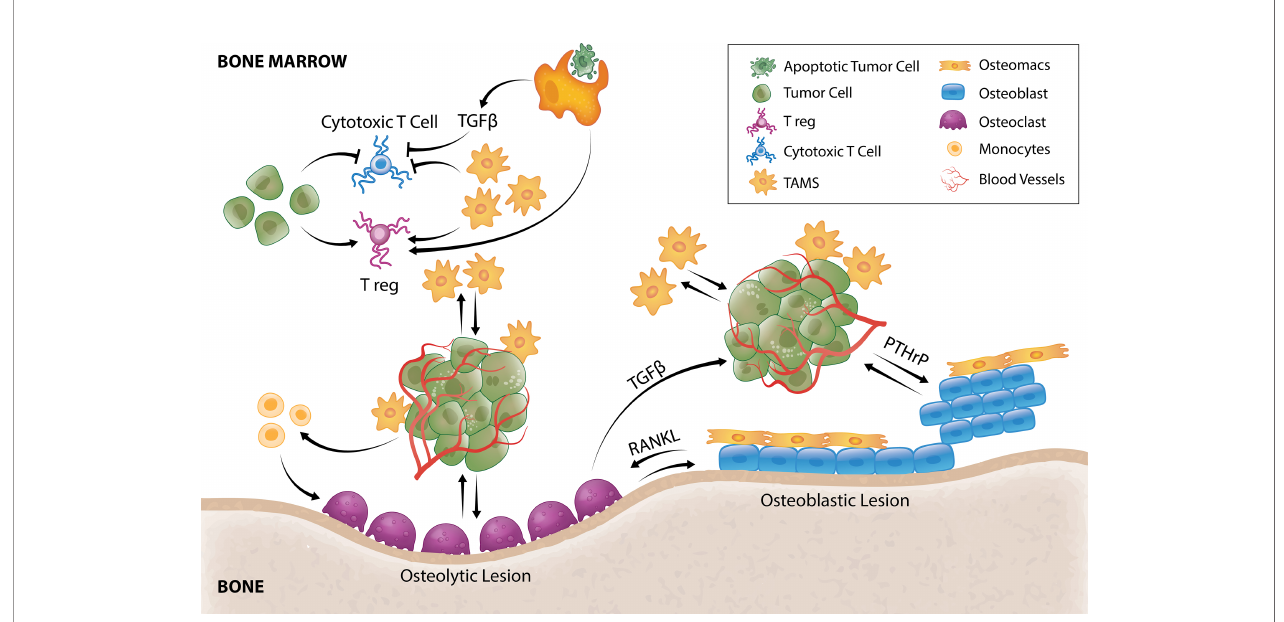
FIGURE 2 | TAM and tumor crosstalk promotes tumor survival and outgrowth in bone. Efferocytosis of apoptotic tumor cells by TAMs results in TGF b secretion that inhibits cytotoxic T cells and stimulates Tregs. TAMs and tumor cells can also directly hijack immune checkpoint pathways to negatively regulate T-cell anti-tumor function. TAMs secrete a multitude of pro-angiogenic factors that induce tumor angiogenesis allowing delivery of oxygen, nutrients and growth factors. Tumor cells can directly stimulate pro-tumorigenic osteoblastic or osteolytic lesion formation and/or recruit TAMs or osteoclast precursors to support these processes. In osteolytic lesions, tumors secrete factors that directly stimulate osteoclastic-mediated resorption to release bone-derived tumor growth factors or stimulate osteoclastogenesis by promoting osteoblast-derived RANKL. Osteoclastogenesis also releases TGF b from the bone matrix that directly stimulates tumor cells to secrete PTHrP that can enhance osteoblasts function to form osteoblastic lesions or enhance osteoblast production of RANKL to form osteolytic lesions. Osteomacs which are abundant within osteoblastic lesions also support osteoblast-mediated bone anabolism, suggesting that they could be a key driver of tumor-induced bone